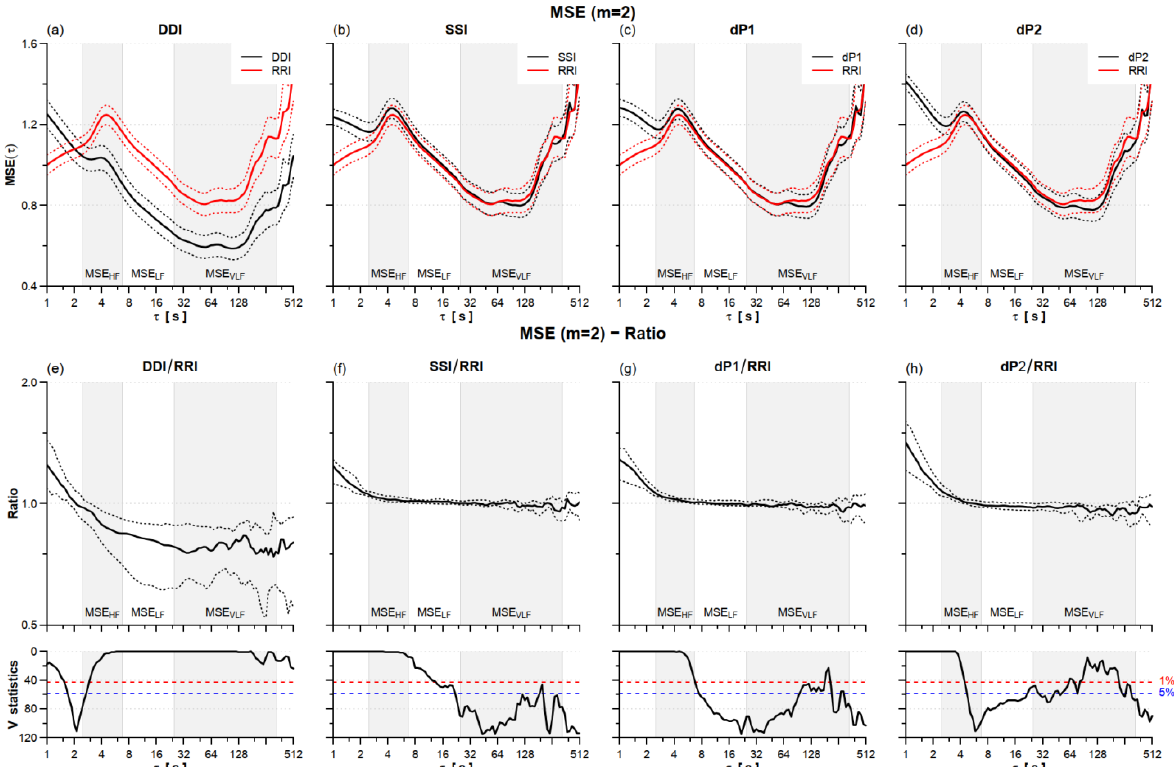
Figure A1. HRV multiscale entropy (MSE) for m = 2 sleeping at high altitude. Upper panels: mean (solid line) ± standard error (dotted line) for MSE of DDI, SSI, dP1, and dP2 (black) and the RRI reference (red) on N = 21 participants (panels ( a – d )). Lower panels: MSE ratio between DDI ( e ), SSI ( f ), dP1 ( g ), and dP2 ( h ) tachograms and the RRI reference: median (solid line) with 1st and 3rd quartiles (dotted line) and V-statistics of the Wilcoxon’s rank test; at the scales where V is above the 5% (or 1%) significance threshold (dashed horizontal line) the ratio differs from 1 at the 5% (or 1%) statistical significance. Grey/white areas indicate the scales for evaluating MSE HF , MSE LF and MSE VLF.